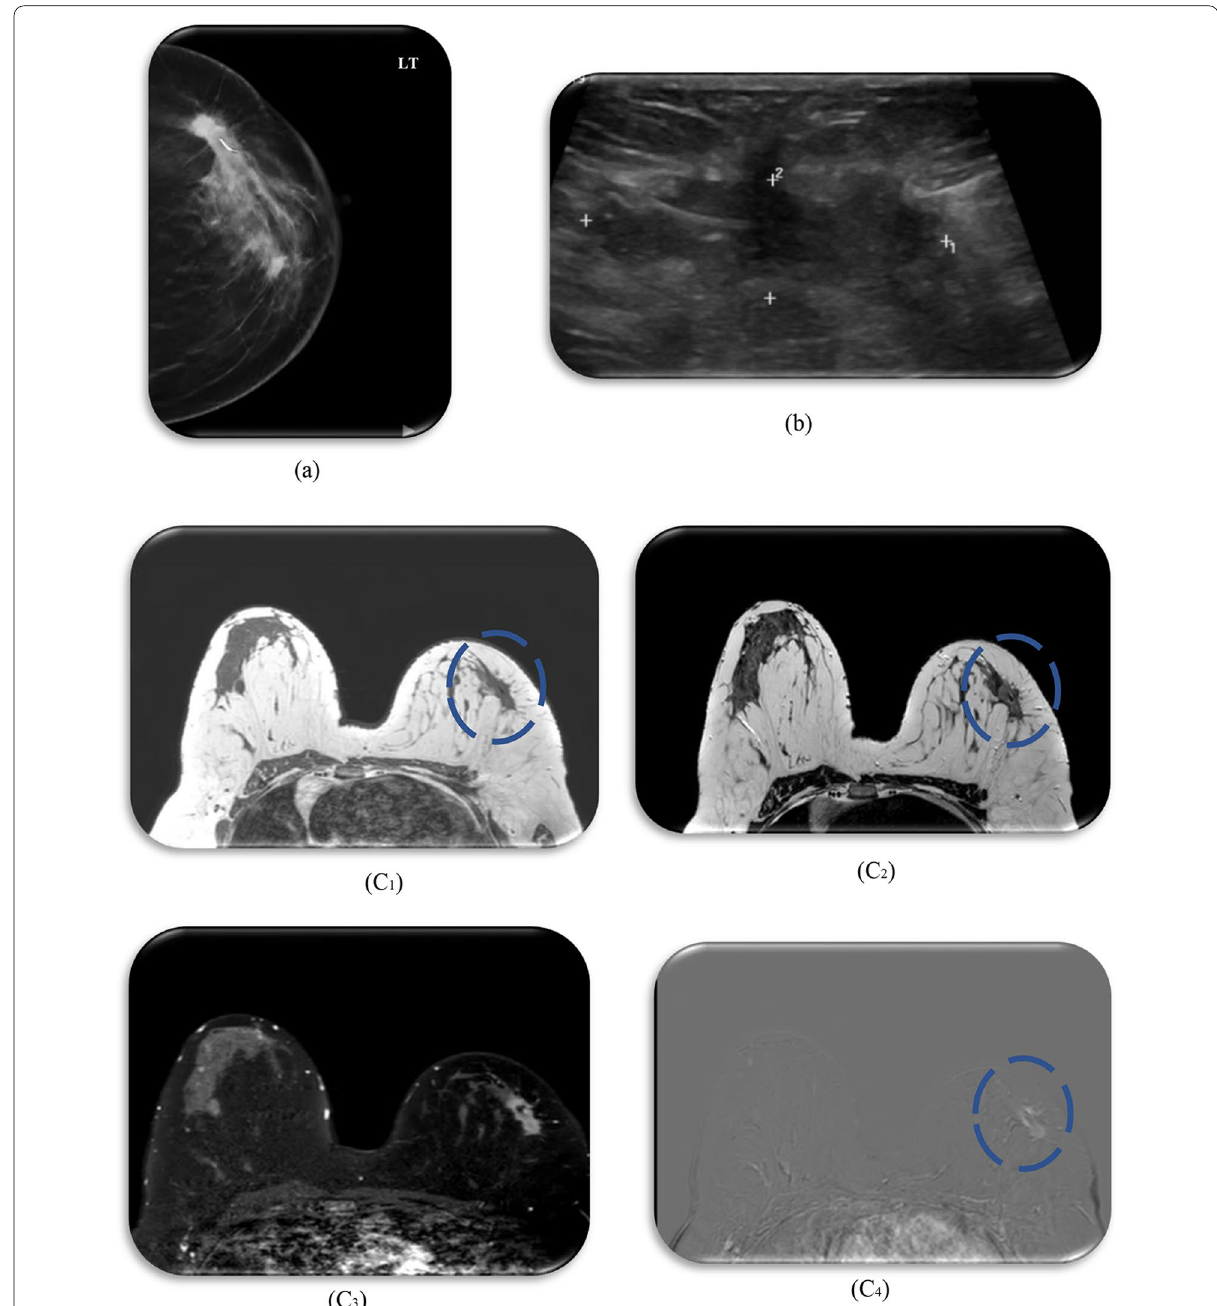
Fig. 8 42-year-old patient with breast lump and axillary masses, the patient came for tru-cut biopsy, which shows advanced breast carcinoma, planned for neoadjuvant chemotherapy and metallic clip placement. The patient received first cycle chemotherapy and came for clip insertion, Breast sonomamography after clip placement a CC view and b ultrasound images showing the metallic clip seen inside the upper outer quadrant mass lesion with no artifact or posterior acoustic shadowing hindering proper visualization of the lesion. MRI of both breasts done after other cycle of NAC c1 T1WIs, c2 T2WIs, c3 post contrast images and c4 subtracted post contrast images) showing the signal void of the inserted surgical clip inside the previously noted breast lesion, with no difficulty in characterization of the lesion. After completing the course of neoadjuvant therapy, follow up sonomamography was done d1 ultrasound image and d2 MLO view showing the surgical clips still seen at the left breast irregular mass lesion which shows appreciable regressive course as regards the size with the clip still seen in the same site compared to the previous studies e ultrasound image shows preoperative wire localization guided by the previously inserted surgical clip due to appreciable regressive course of the size of the